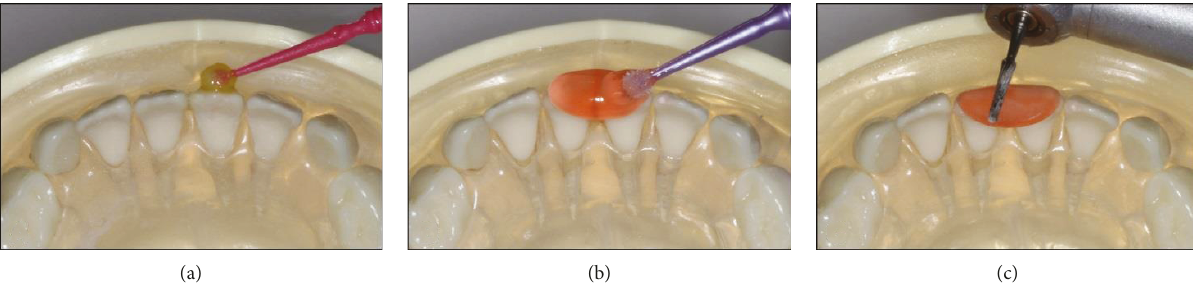
Figure 5: (a) Rubbing the facial and incisal surfaces with a self-etch adhesive L-Pop ™ . (b) Applying the Triad® Gel with a microbrush. Alternatively, it can be applied with a repurposed fl owable syringe. (c) Beveling the cured material lingually with a handpiece.